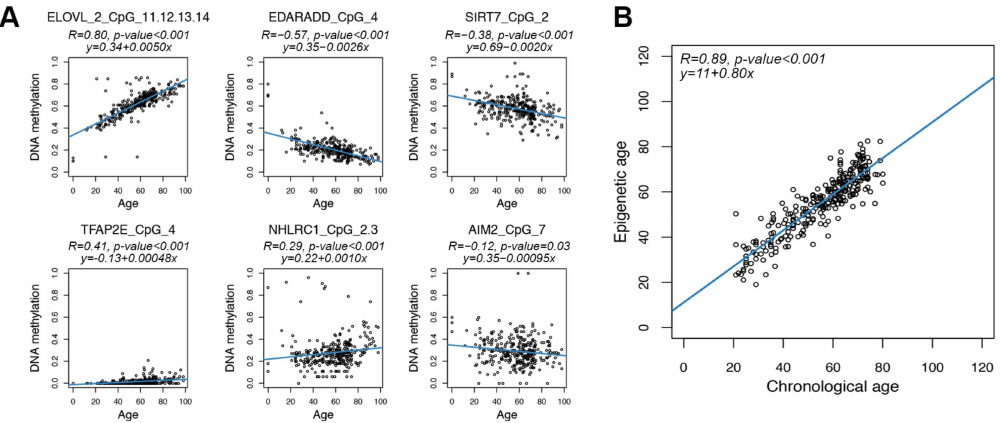
Figure 2. Age prediction using the targeted epigenetic clock. Each dot represents a subject. ( A ) Scatter plots of DNAm values vs. chronological age for the 6 regions assessed by the targeted assay. For each region, the CpG unit with the most significant Spearman correlation is reported. Blue lines represent linear regressions. For each CpG unit, Spearman correlation coefficient and the equation of the regression line are reported. ( B ) Epigenetic age ( y -axis) vs. chronological age ( x -axis) in CTR. The blue line represents linear regression. Spearman correlation coefficient and the equation of the regression line between epigenetic and chronological age are